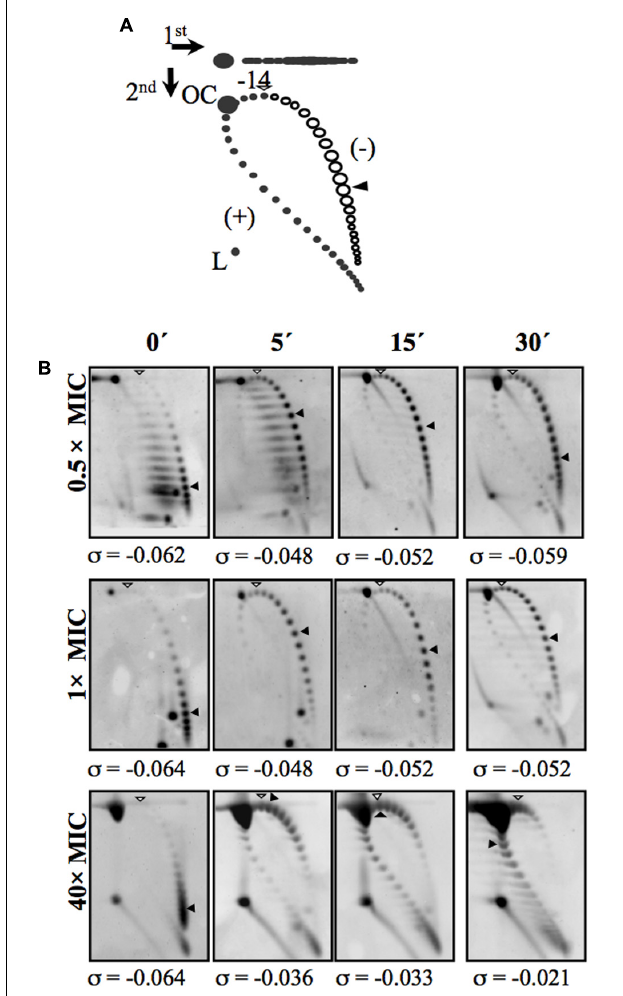
FIGURE 3 | Treatment with the GyrB inhibitor NOV causes relaxation and subsequent recovery of supercoiling levels. (A) Diagram showing plasmid pLS1 topoisomer distribution after two-dimensional electrophoresis in agarose gels run in the presence of 1 and 2 µ g/ml chloroquine in the first and second dimensions, respectively. Arrows at the top left corner indicate the running direction of the first and second dimensions, respectively. OC, open circle; L, linear form. Negative supercoiled topoisomers are in white and positive supercoiled topoisomers in black. 2 µ g/ml chloroquine introduces 14 positive supercoils. A white arrowhead indicates the topoisomer that migrated with (cid:49) Lk of 0 in the second dimension; it migrated with a (cid:49) Wr of –14 in the first dimension. A black arrowhead indicates the most abundant topoisomer. (B) pLS1 topoisomer distribution after different NOV treatments. Samples were taken before the addition of the drug (time 0 min) and at the times indicated. The corresponding supercoiling density ( σ ) value is indicated below each autoradiogram. Taken from Ferrándiz et al. (2010), with modifications.